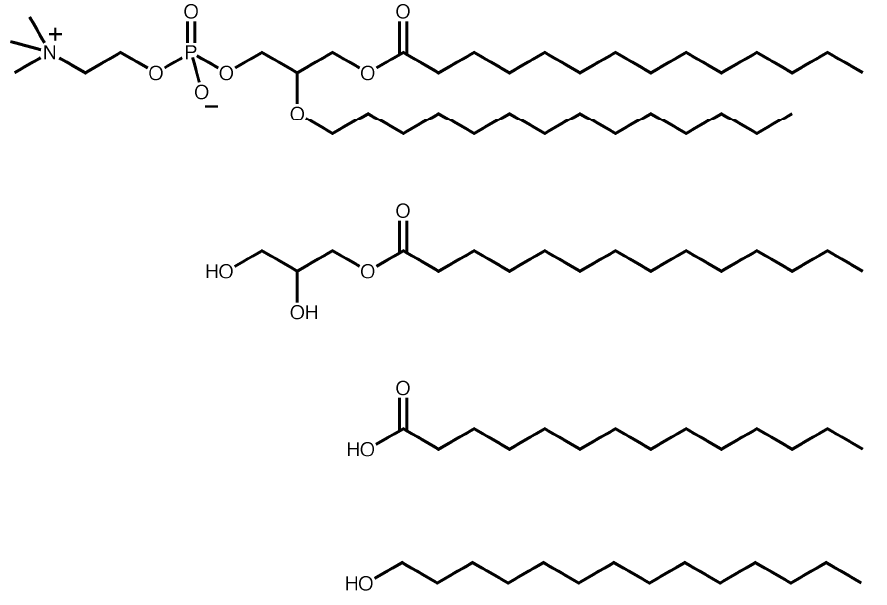
Figure 1. Chemical structures of representative single-chain and double-chain lipids. From top to bottom, the molecules are dimyristoyl phosphatidylcholine (DMPC), monomyristin, myristic acid, and